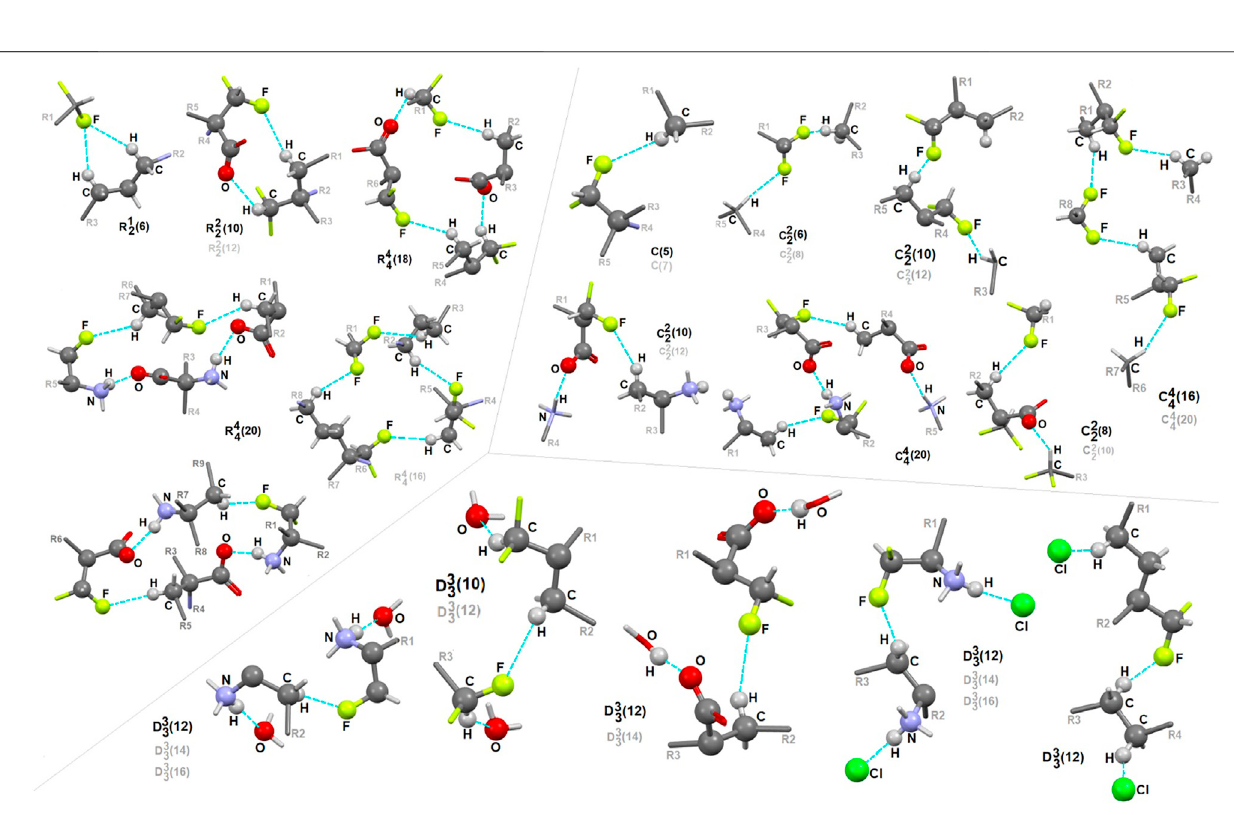
Frontiers in Chemistry |